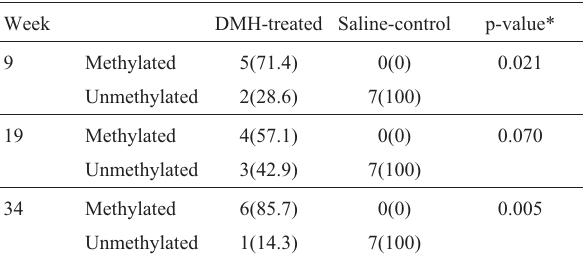
Table 3 - Differences in p16 hypermethylation between DMH-treated and saline-control groups in stool samples.